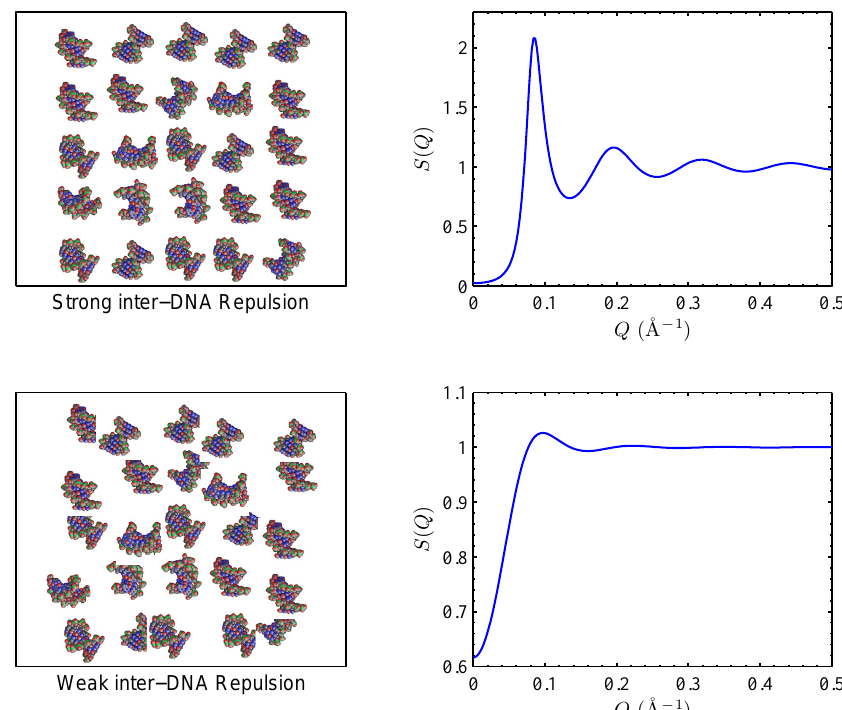
Figure 7. Application of small angle X-ray scattering (SAXS) to measure the structure factor S ( Q ) of semi-dilute dispersions of oligomeric DNAs. The top panels show the case of strong DNA–DNA repulsion, giving rise to spatial ordering of DNA strands and a structure factor with pronounced correlation peaks. The bottom panels show the case of weak DNA–DNA interaction, giving rise to random dispersions and a much suppressed structure factor.